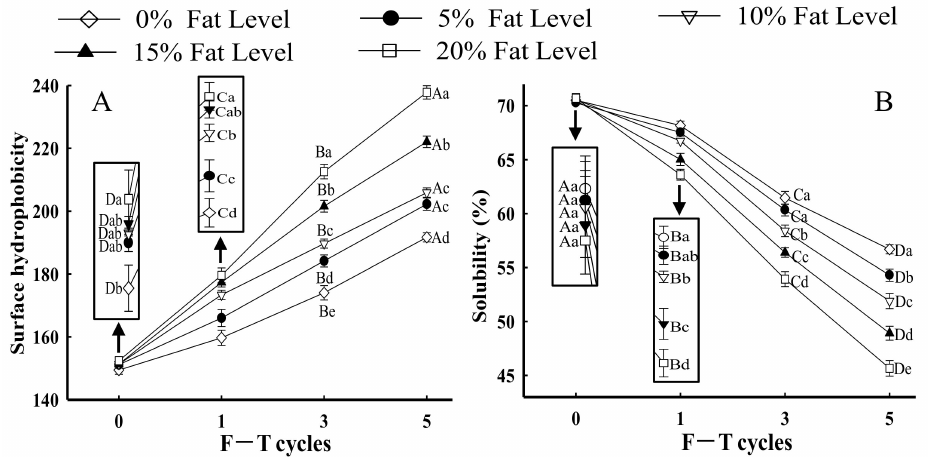
Figure 1. Influence of F–T cycles on surface hydrophobicity ( A ) and solubility ( B ) of myofibrillar protein from quick-frozen patties with different fat levels. Values are given as the mean ± SE. The means for the same fat levels with different uppercase letters (A to D) and the same F–T cycles with different lowercase letters (a to e) differed significantly ( p <